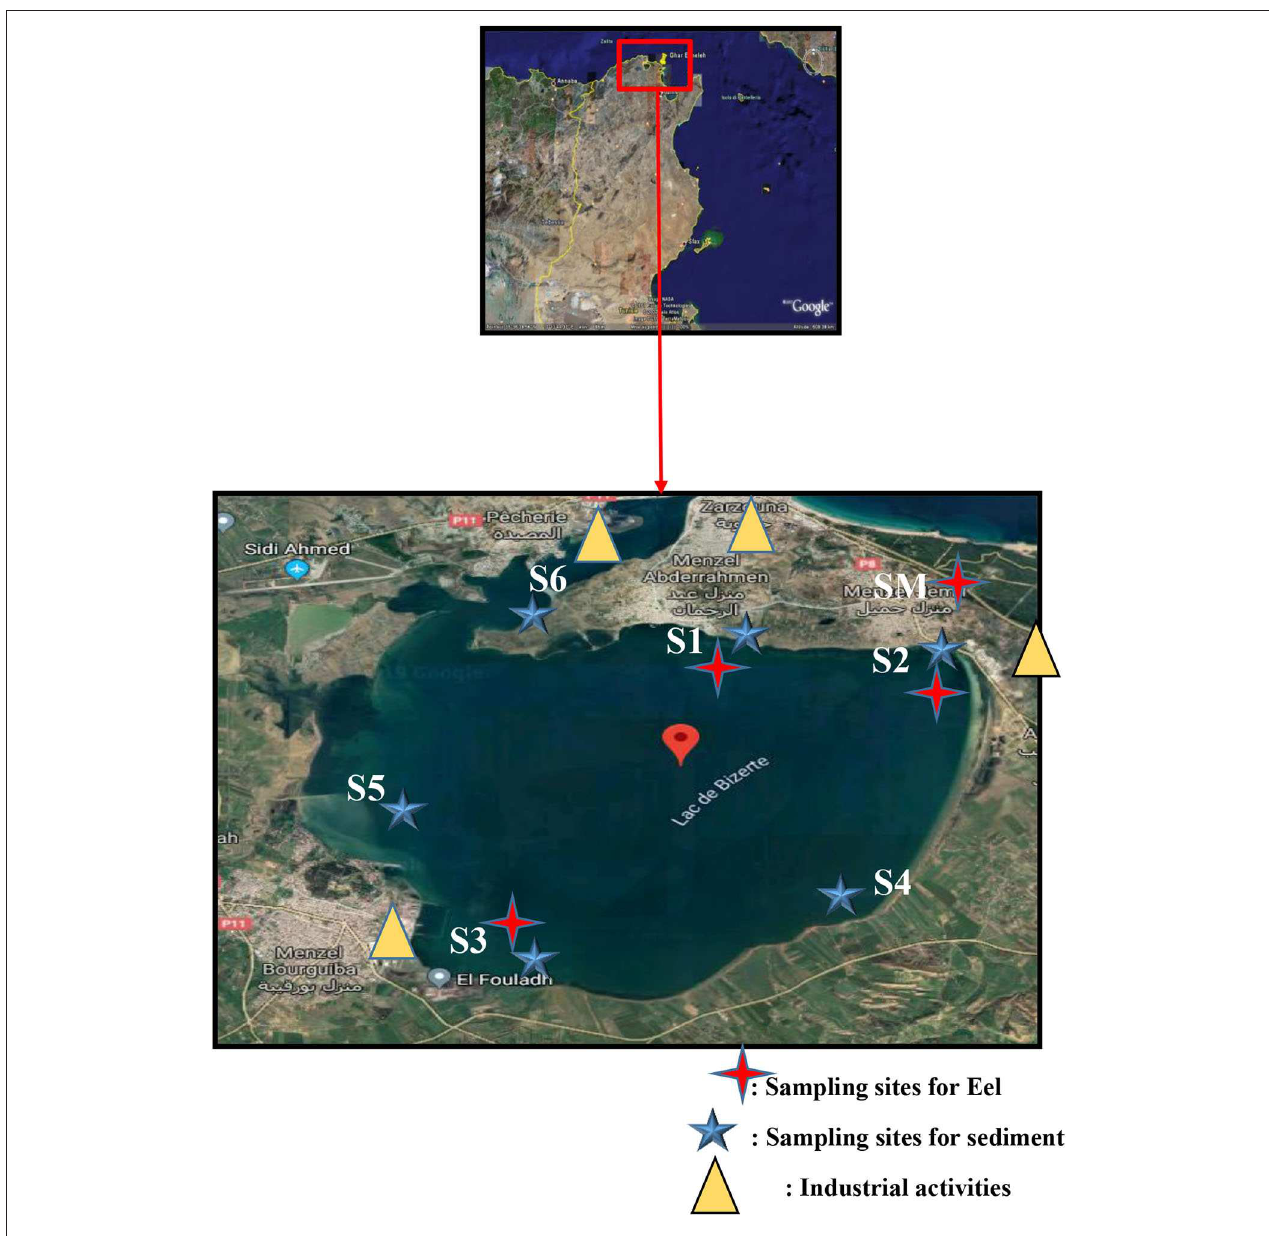
FIGURE 1 | Sediment and eel sampling